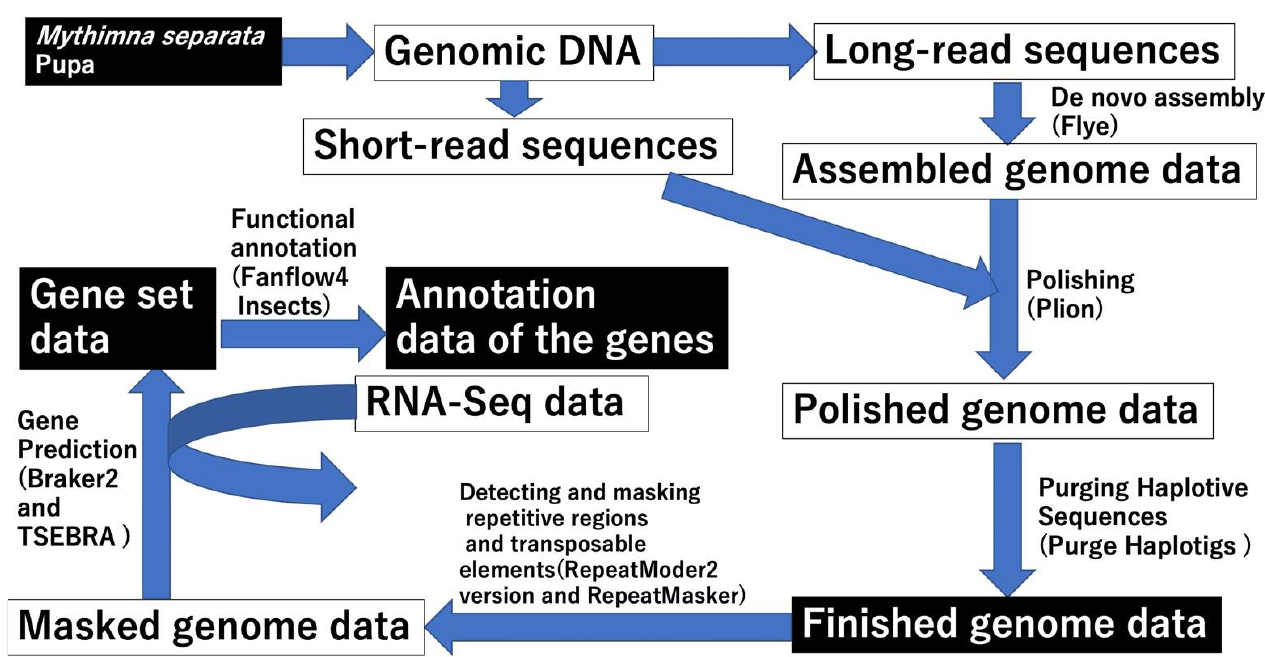
Figure 1. Schemes of reference genome construction, gene prediction, and functional annotating. “Finished genome data” indicates the reference genome data. The names of software used in each step are shown in brackets.